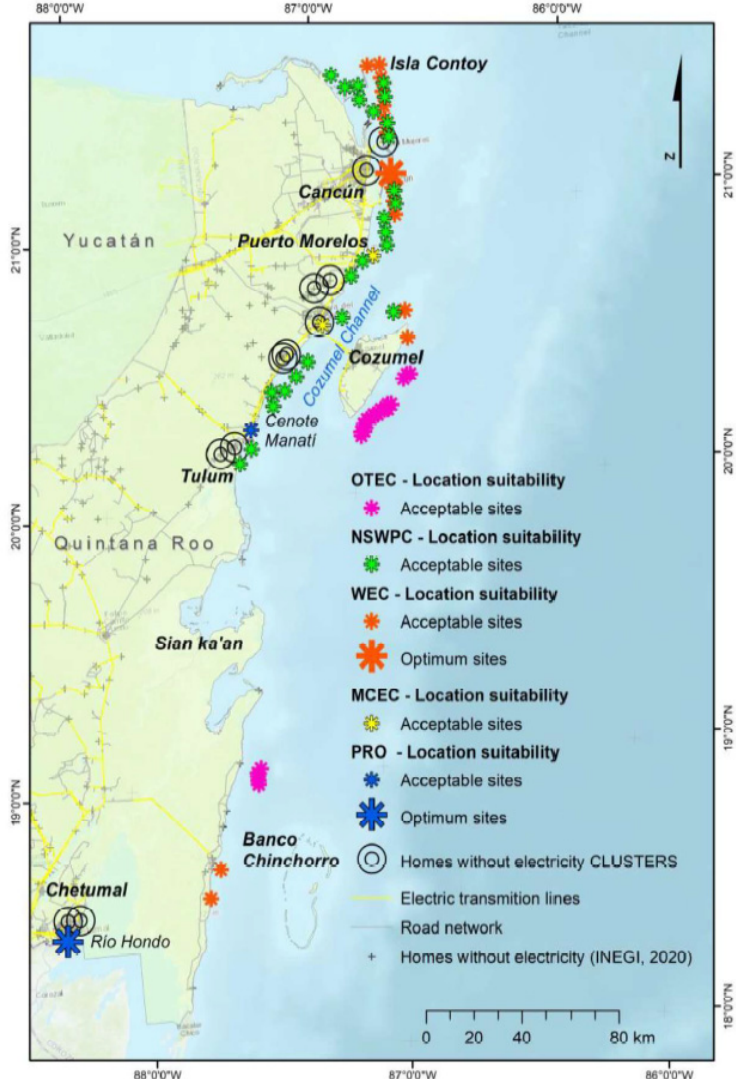
Figure 3. Suitable locations for energy in the study area for five potential energy sources from [27]. Sites for Marine Current Energy Converters (MCEC) are shown by yellow asterisks.